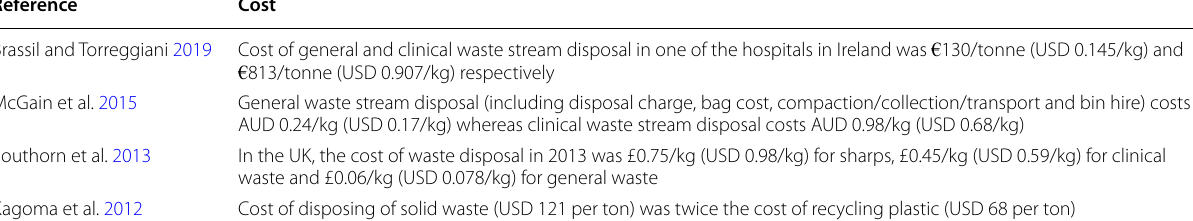
Table 1 Disposal cost for each type of waste Reference